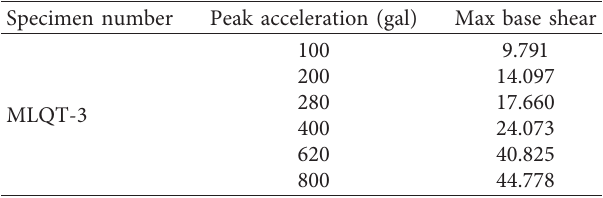
Table 7: Maximum shear with peak acceleration (MLQT-3). Specimen number